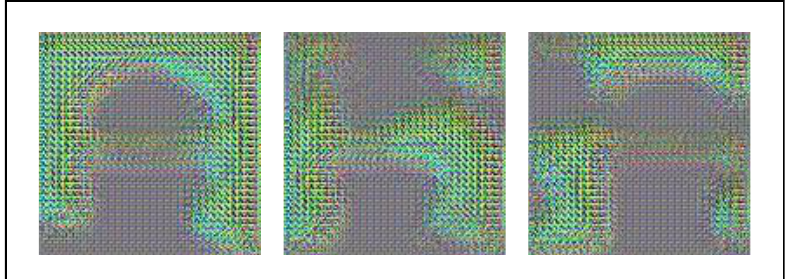
Figure 11. The result of ignoring the MSE.